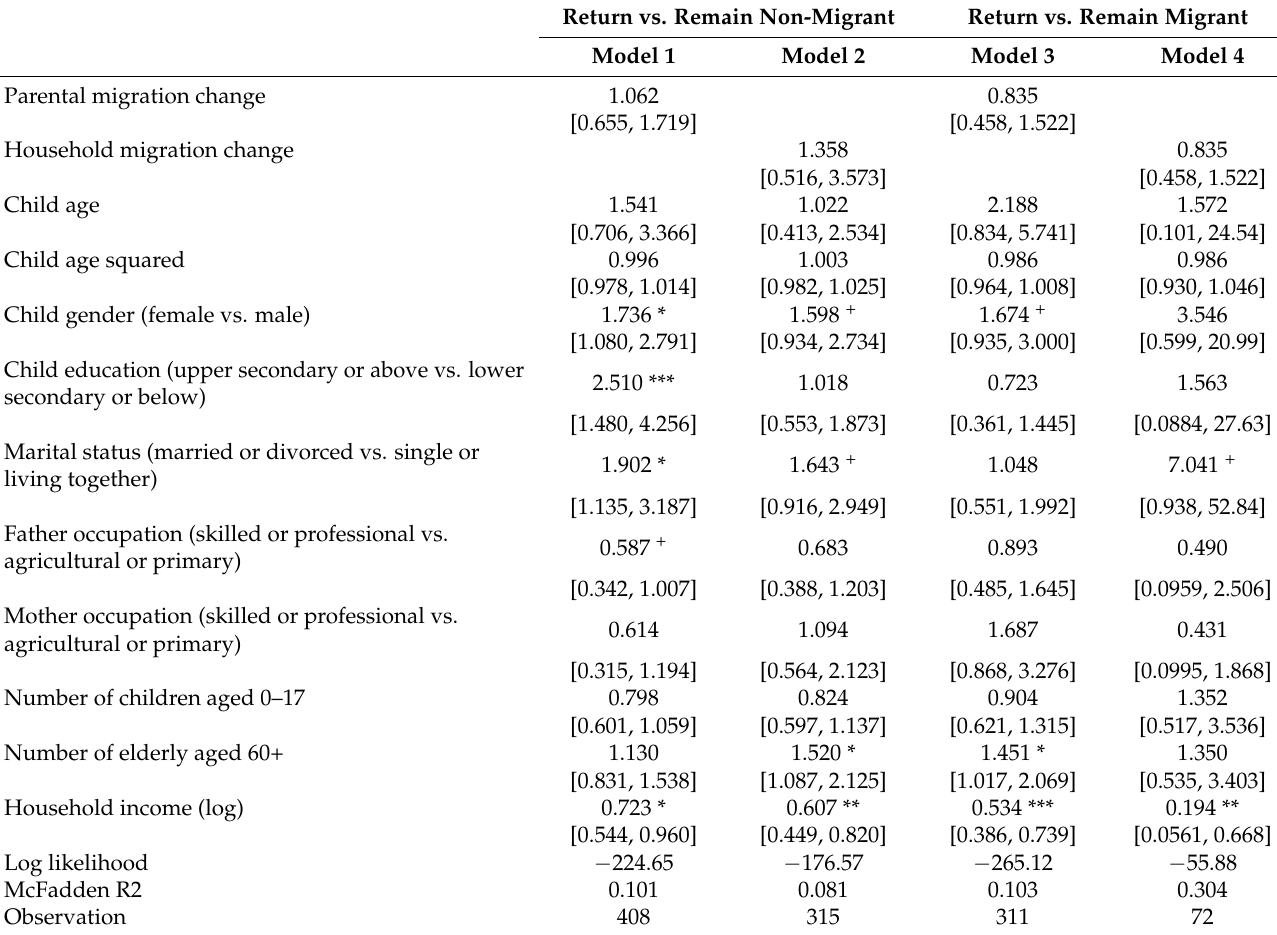
Table A2. Effects of relay migration on youth labor migration with different comparison